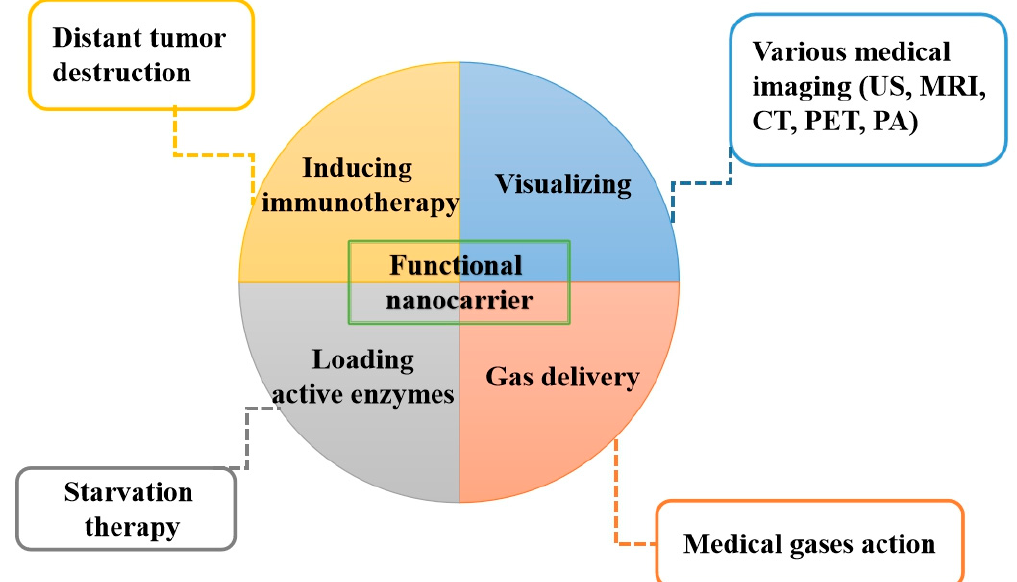
Figure 4. Nanoparticles can act as a tumor targeted carrier to deliver photosensitizers to a deep-seated tumor with additional functions. US: Ultrasound, MRI: Magnetic resonance imaging, CT: Computed tomography, PET: Positron emission tomography, PA: Photoacoustic.